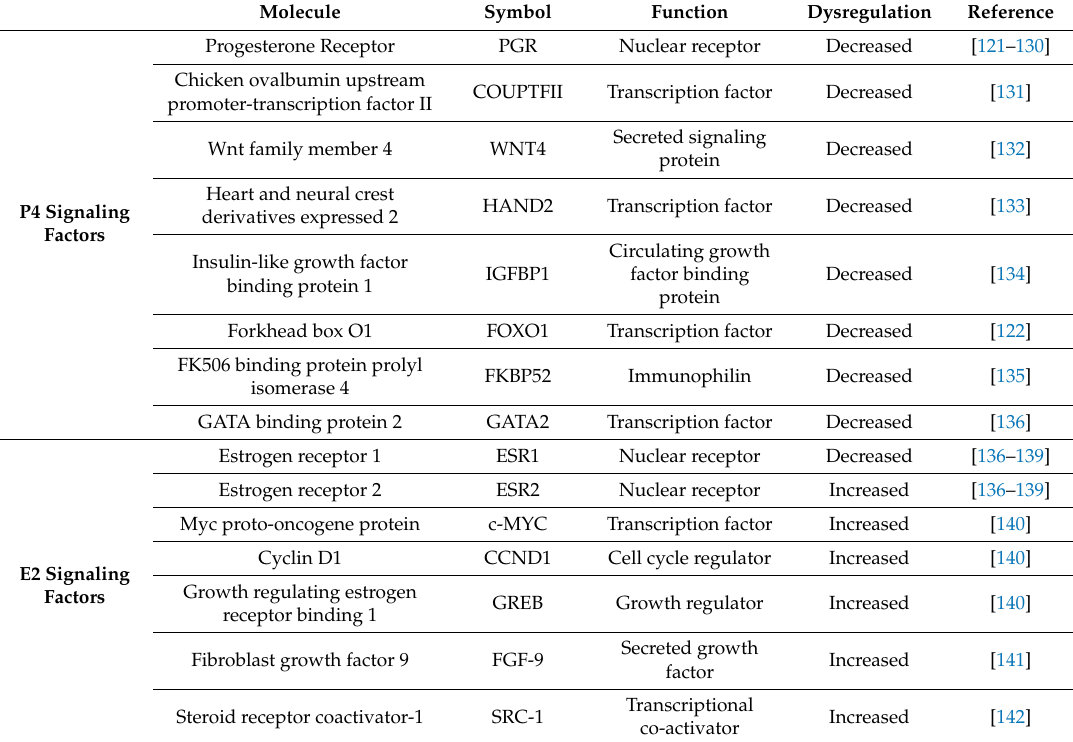
Table 1. P4 and E2 signaling factors dysregulated in endometriotic